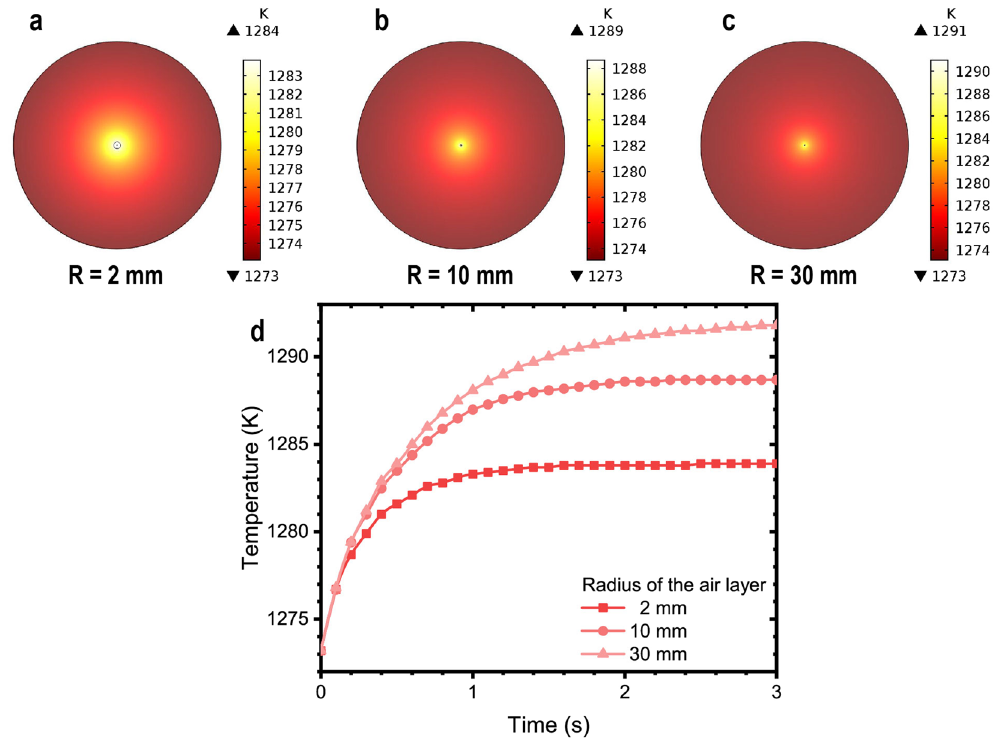
Figure 2. Simulated temperature field around the fiber. ( a – c ) Are of different radiuses of the air layers R = 2, 10 and 30 mm, respectively. ( d ) The highest temperatures of the fiber increasing with